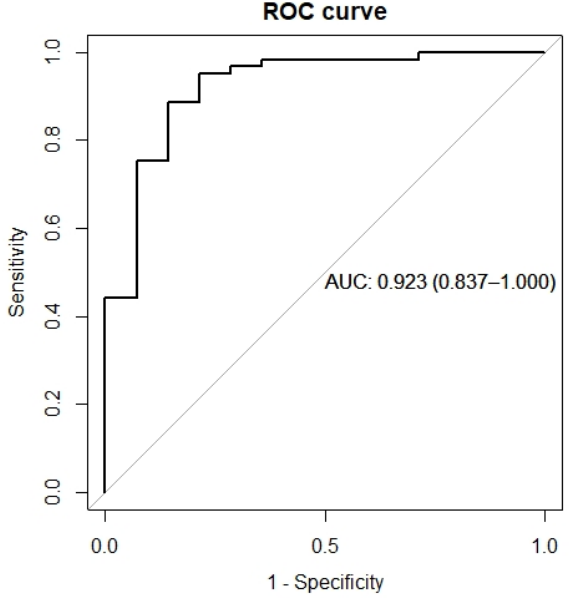
Figure 4. Receiver operating characteristic (ROC) curve of the diagnostic model for esophageal dysmotility in SSc.